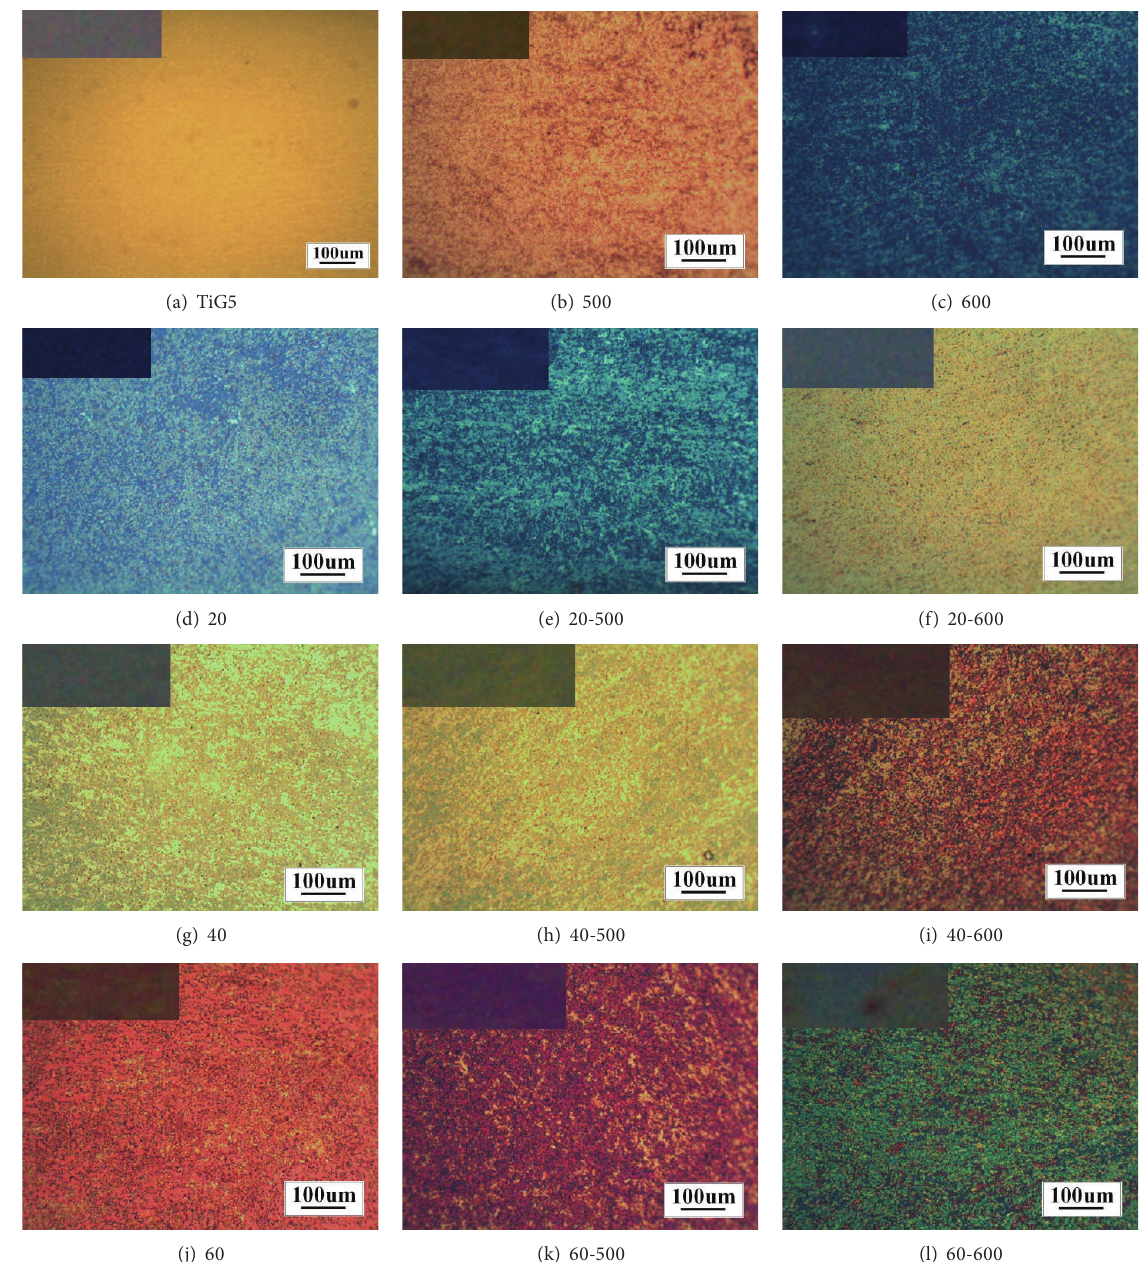
Figure 1: Macrographs and micrographs of anodically oxidized samples at 20, 40, and 60 V, with and without subsequent heat treatment at 500 and 600 ∘